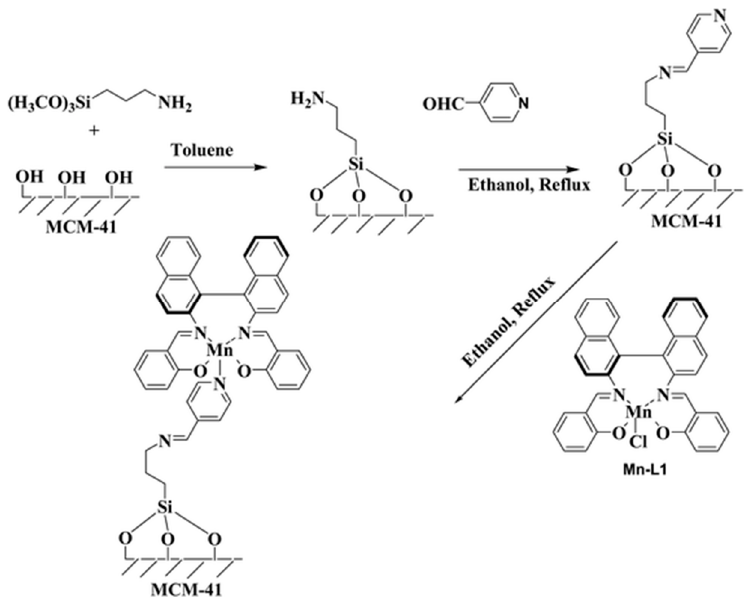
Figure 37. Synthesis of MCM-41 supported Mn-Schiff base complexes. Reproduced with permission from [52]. Copyright 2015 Royal Society of Chemistry.